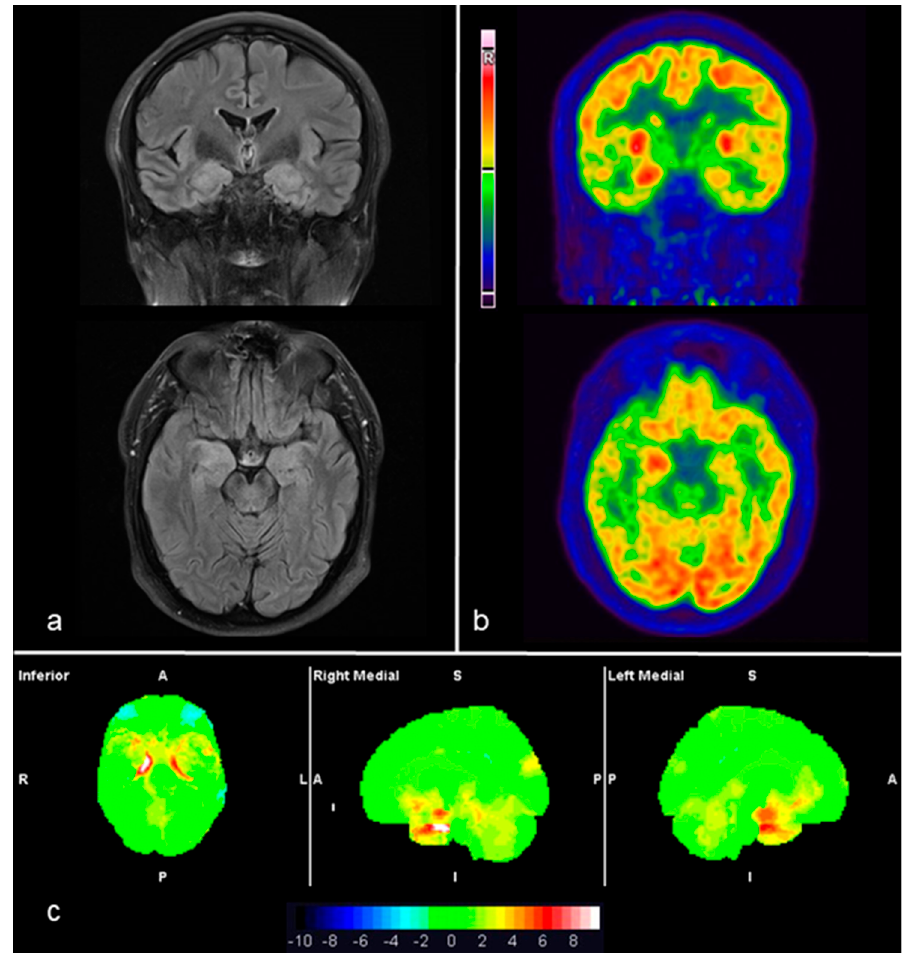
Figure 3. Example of anti-CASPR2 (case 3): MRI-3T, T2-FLAIR axial and coronal slices ( a ) show medial temporal hyperintensity as well as swelling, predominantly on the right side. Corresponding 18F-FDG-PET/CT axial and coronal slices ( b ) showing right medial temporal hyperactivity. The syngo.via Database Comparison based analysis of FDG-PET images ( c ) exhibited a significant bilateral medial temporal hypermetabolism on the statistical surface projection (in red) with respect to a normal database. In the displayed syngo.via Database Comparison, the significant voxels can be identified according to the SD color bar, 2 SD being the threshold of statistical significance (i.e., areas with green voxels are not significant and areas with orange to red voxels are significant increases).